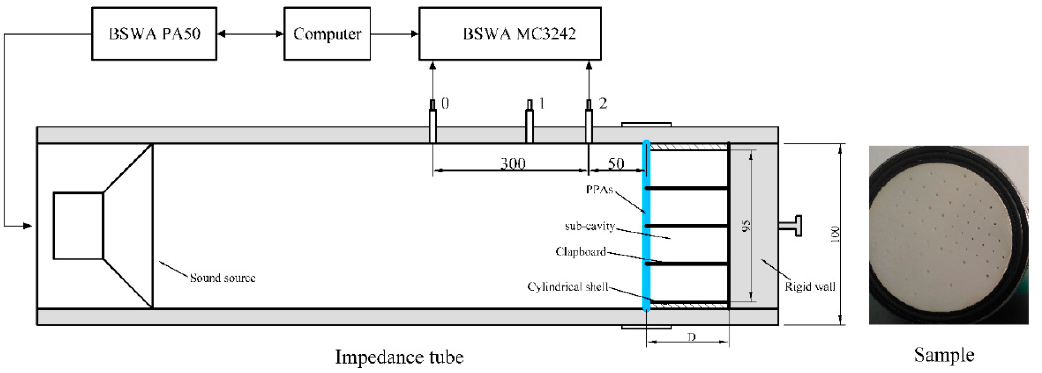
Figure 5. The experimental Setup.